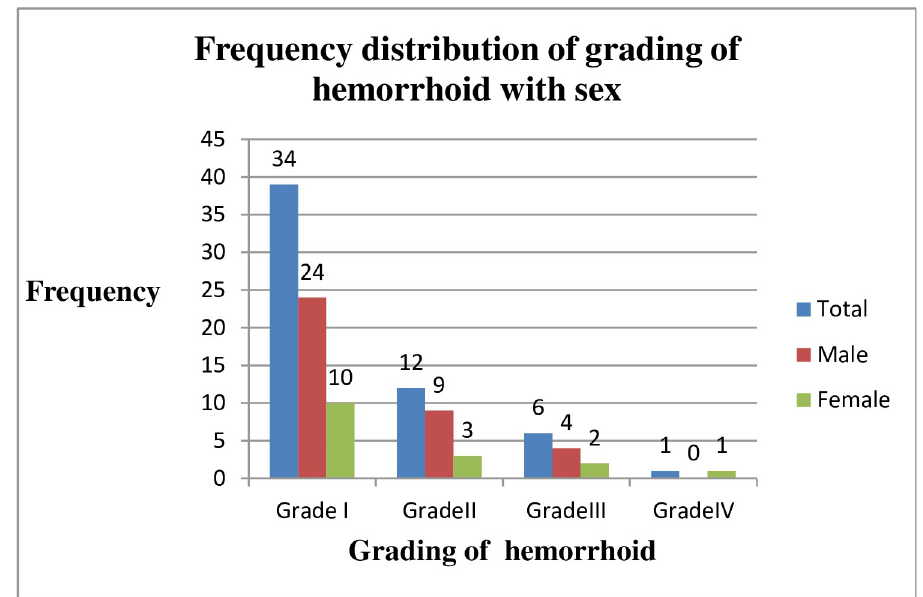
Fig 1. Frequency distribution of grading of hemorrhoid with sex of adult patients visiting surgical OPD at the UOG Comprehensive Hospital, Ethiopia, 2020.